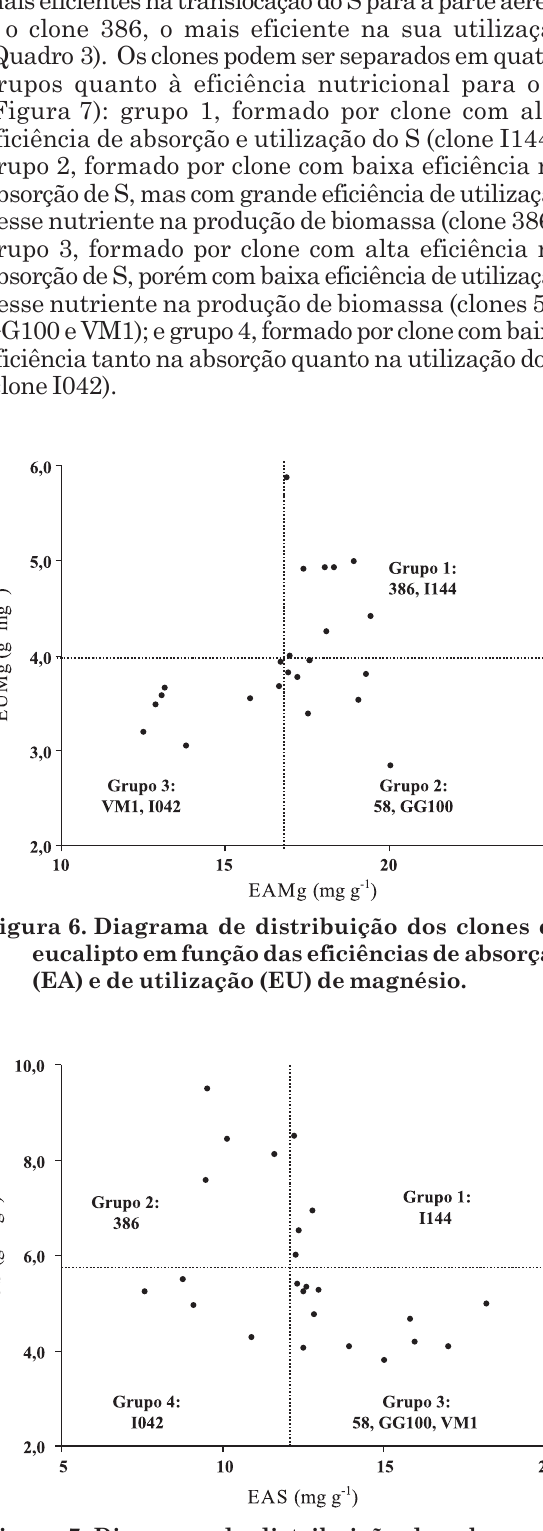
Figura 7. Diagrama de distribuição dos clones de eucalipto em função das eficiências de absorção e utilização do